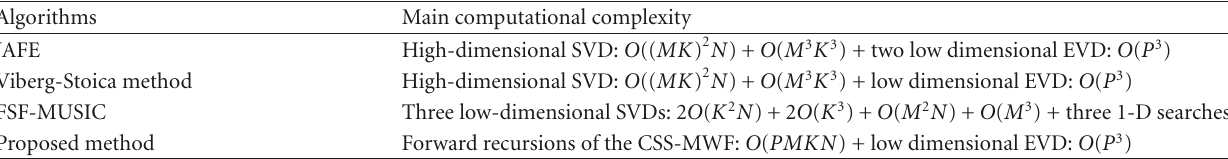
Table 1: Comparisons of the computational complexity of various algorithms.